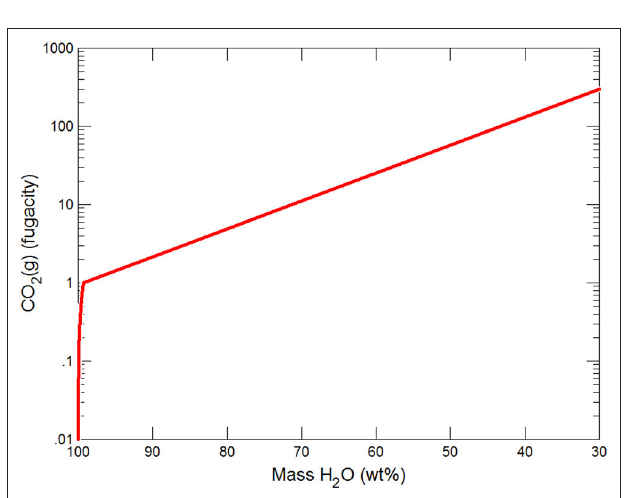
FIGURE 4 | Variations in pCO 2 during freezing of glacial water.